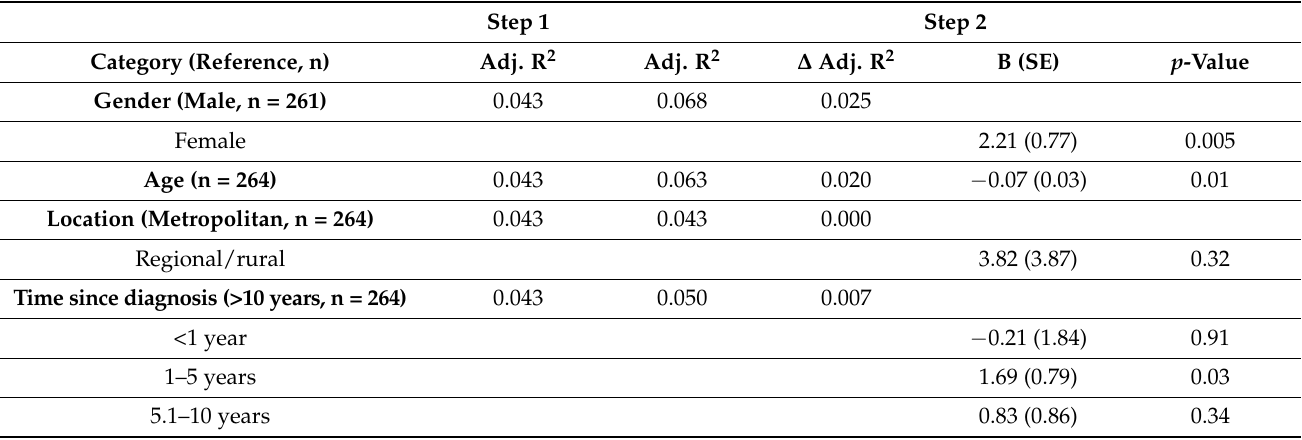
Table 3. Linear regression predicting the Oxford COVID-19 Vaccine Hesitancy Scale score using socio-demographic and clinical